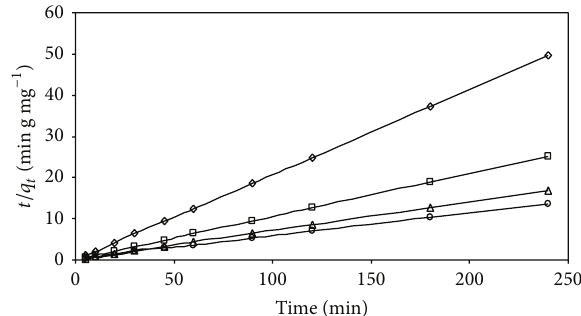
Figure 8: Effect of initial concentration and contact time on CR adsorption. Conditions: AB25 concentration: ◊ : 25 mg L −1 ; ◻ :